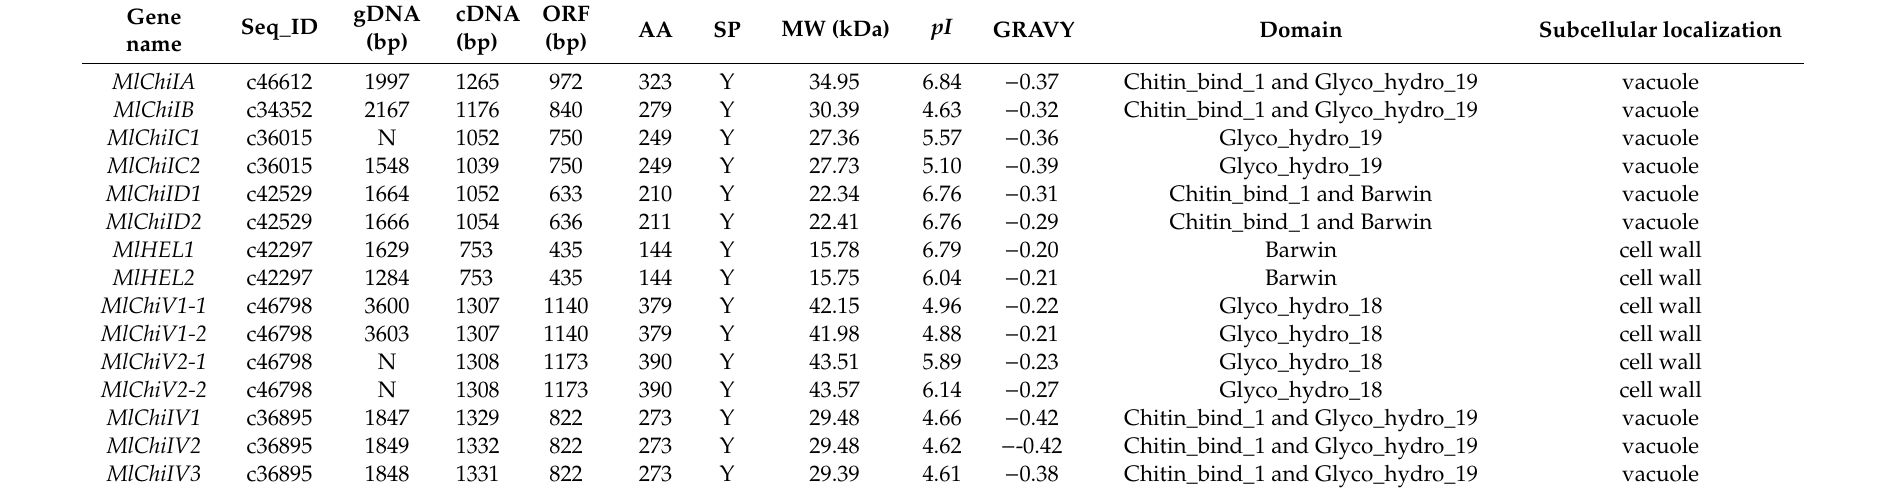
Table 3. Characteristics of the fifteen MlChi genes isolated from M. laevigata in this